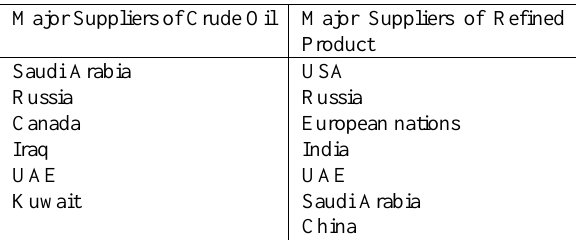
Table 1. Major suppliers of crude oil & refined